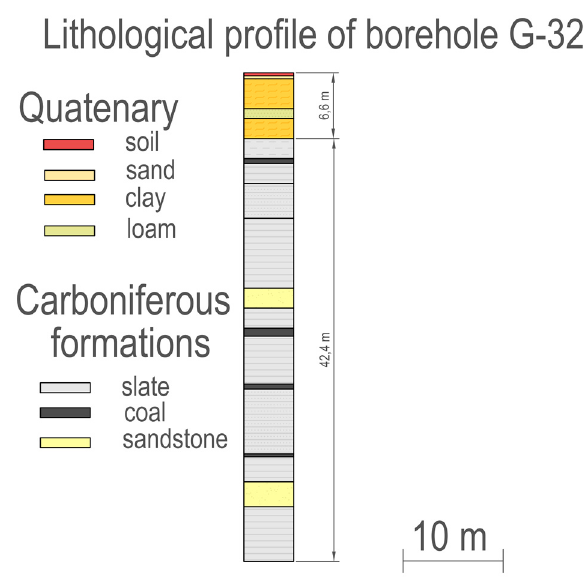
Figure 7. Lithological profile of the rock mass (borehole G-32). The location of the borehole is shown in Figure 5.